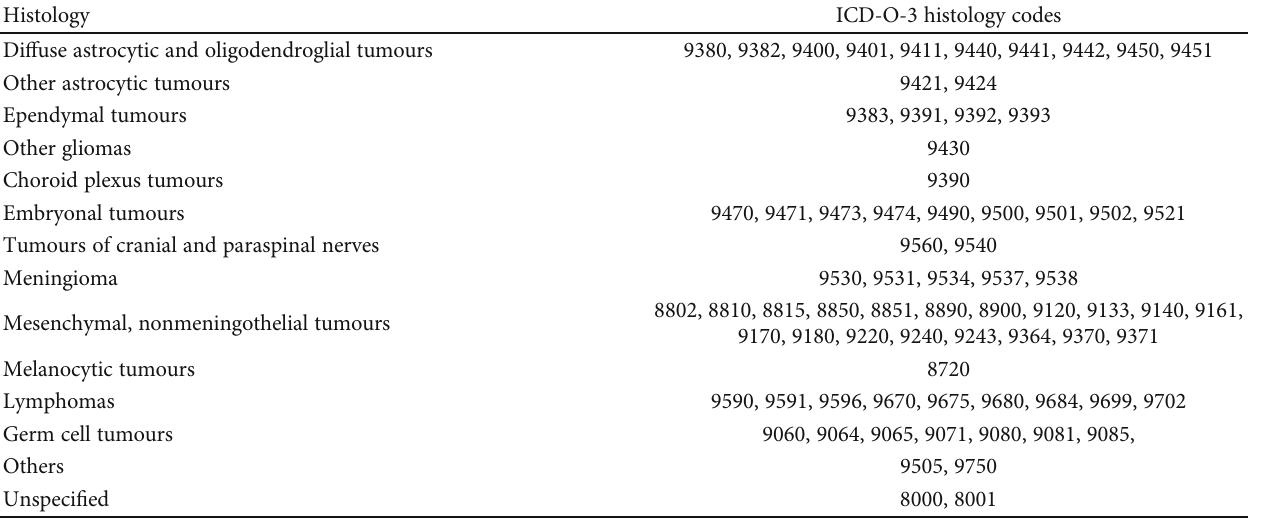
Table 2: ICD-O-3 histology codes.